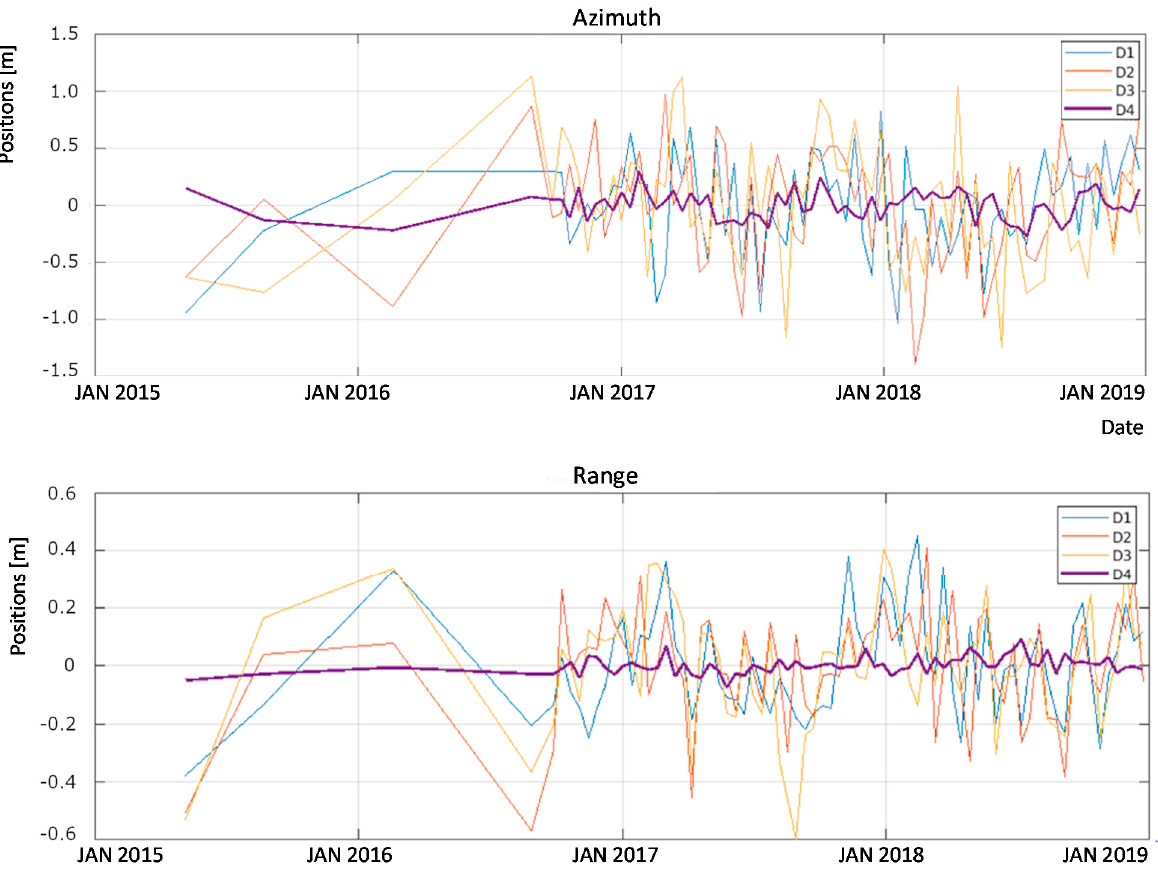
Figure 13. Displacements registered for each considered dune (D1, D2, and D3) and the control point D4: shifts along the azimuth (nearly north-south) direction ( top ); shifts along the range direction (nearly east-west) ( bottom ).